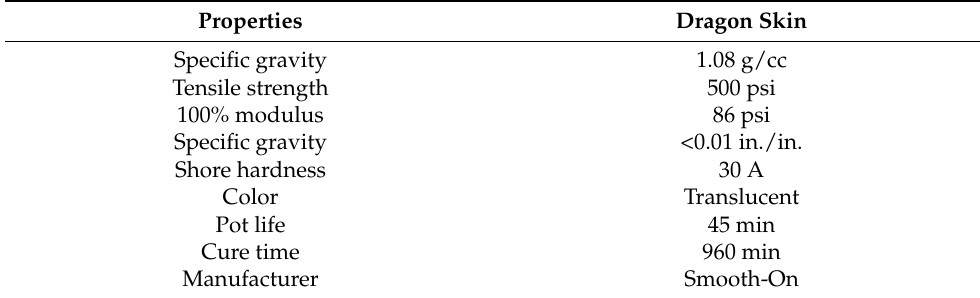
Table 1. Material properties of Dragon Skin 30